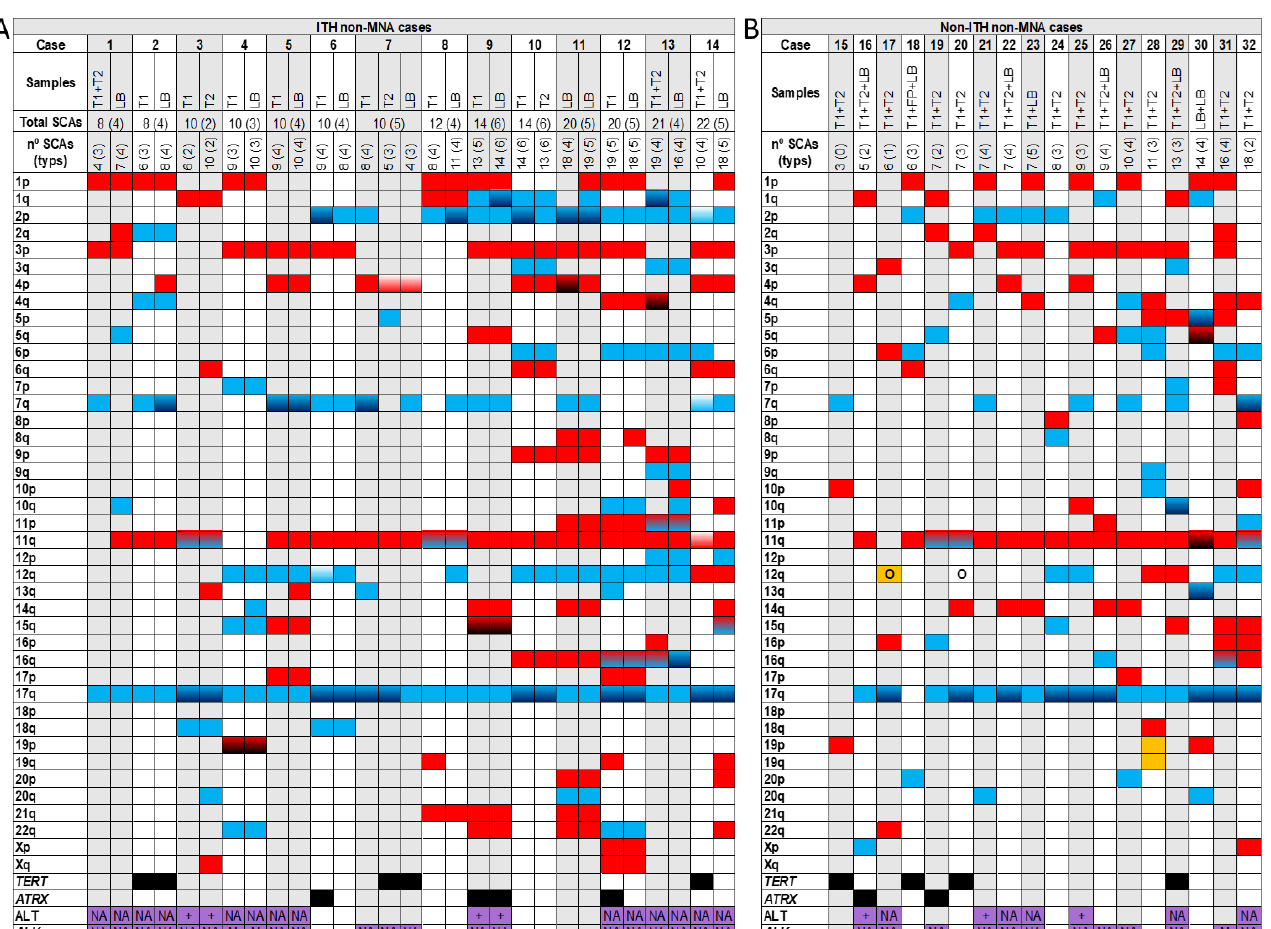
Figure 1. Genomic aberrations found by SNPa in MYCN non amplified cases (non-MNA) with intra-tumour heterogeneity (ITH) ( A ) and non-ITH ( B ). In the upper part of both Figures A and B the analysed samples (T: solid tumour -1, 2-; LB: liquid biopsy) corresponding to each case (1–32) with the total number of segmental chromosomal aberrations (SCAs) and the typical ones in parenthesis, are shown. In Figure 1A the total number of SCAs and typical ones of each case, taking into account all the analysed samples, are also presented. Solid blue or red squares refers to gains or losses, respectively in the indicated chromosome arm. Gradient color from blue or red to black indicates gains or losses with two or more chromosome fragments in the chromosome arm. Gradient color from white to blue or red indicates changes in the break position (which results in size variations of the aberration) in the chromosome arm between the analyzed samples of a case (only in ITH ones). Gradient color from blue to red refers to both gains and losses in the same chromosome arm of a sample. Solid yellow squares indicate the presence of a chromotripsis-like phenomenon. Black squares indicate the presence of focal segmental chromosomal aberrations (FSCAs) affecting TERT or ATRX genes. Purple squares indicate that the samples have been analysed for alternative lengthening of telomeres (ALT) or for mutations and amplifications in the ALK gene; NA: in the squares indicates that any aberration has been detected in the sample; +: refers to the presence of ALT; A: refers to presence of ALK amplification; M: indicates ALK mutation. O: indicates amplification of any gene or region in the chromosome arm, excluding MYCN or ALK